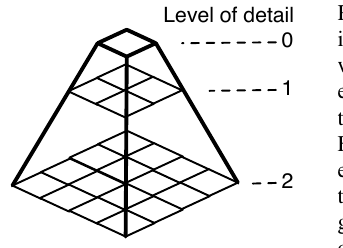
Raster and elevation data is structured as a pyramid with increasingly higher lev- els of detail (LOD) toward the bottom, as illustrated in Figure 3. The rendering engine mimics this struc- ture as a quad-tree scene graph. Each LOD consists of 2 2 n tiles, where n is the LOD. As the LOD goes up, the resolution of the asso- ciated LOD increases. For instance, at LOD zero,